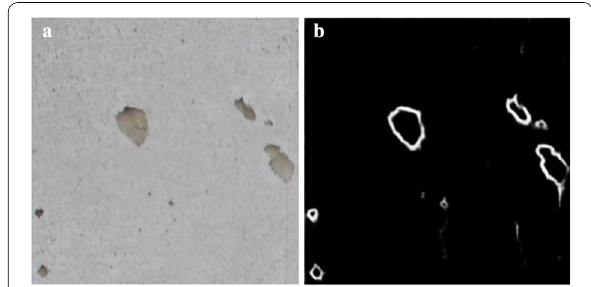
in the lower part than in the upper part. Compared to Fig. 8a, crack lines detected from Fig. 7 are similar to those obtained from optical observation. For the more